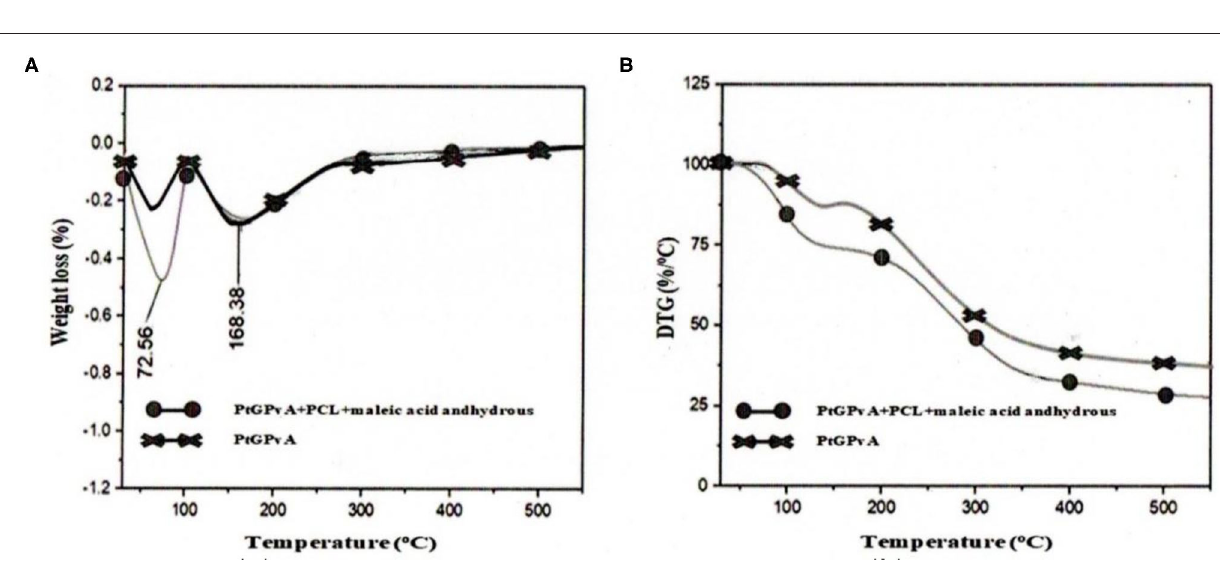
FIGURE 10 | Relationship between temperature with (A) weight loss (B) derivative of thermogravimetry of MSGPvA BtC with and without PCL and